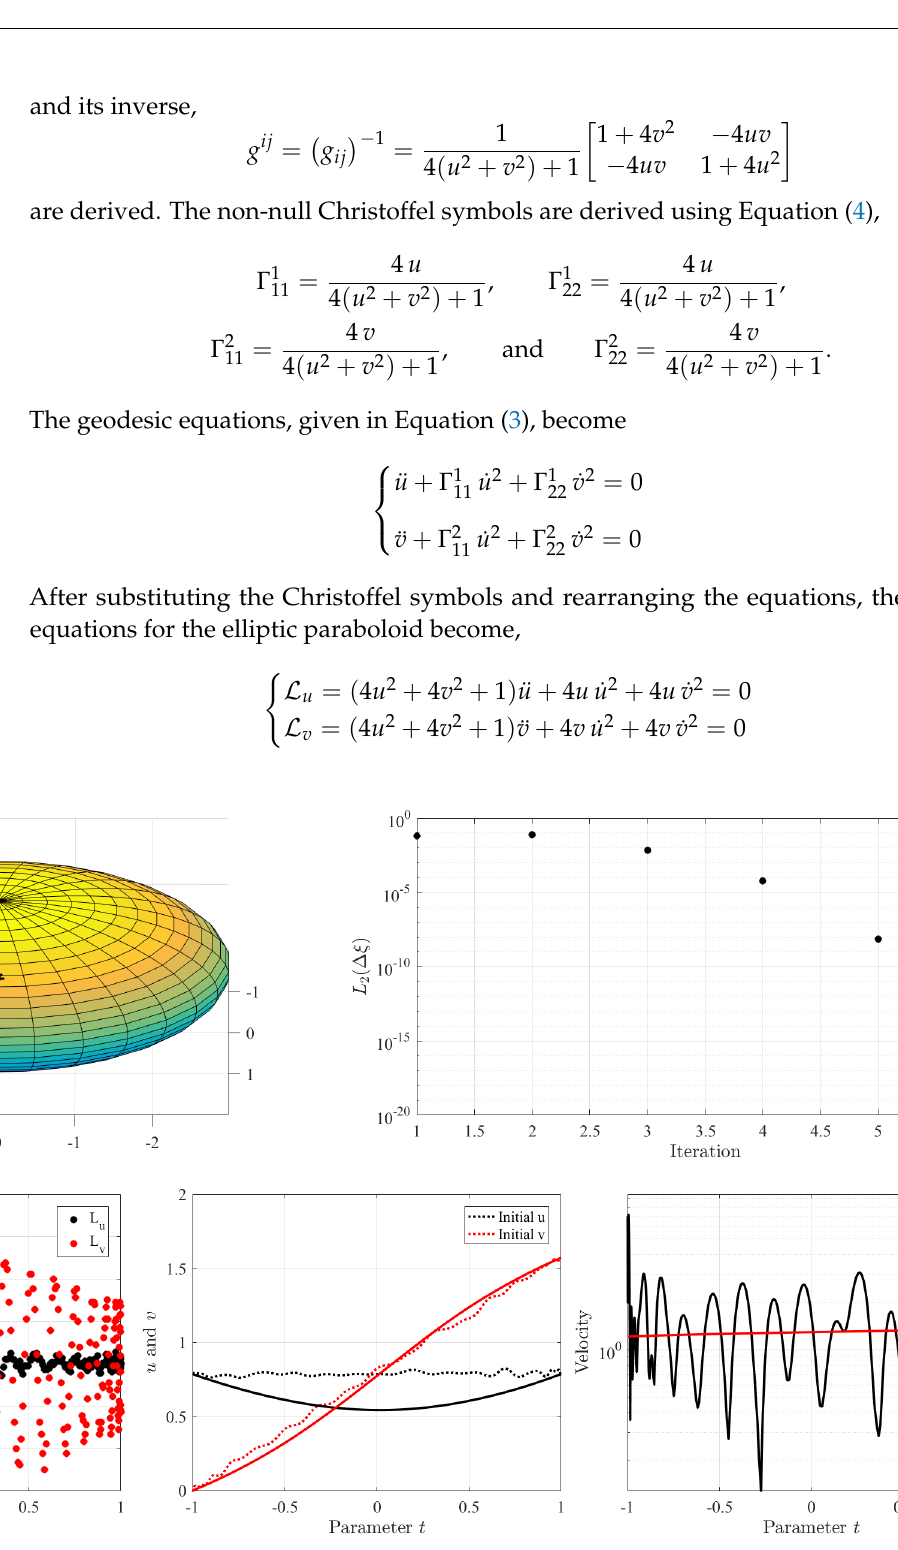
Figure 3. Numerical validation test on triaxial